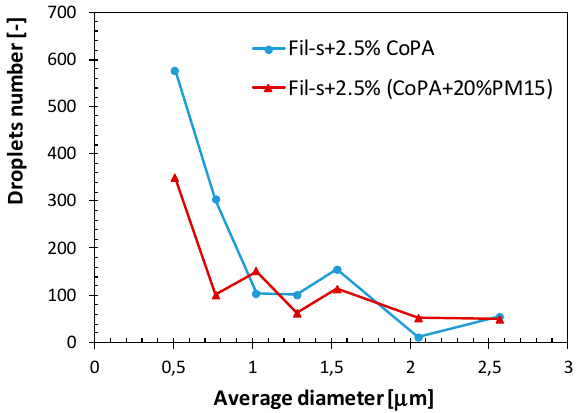
Figure 8. SEM image of the sample Fil-s + 2.5%(CoPA+20%PM15) captured on the section cryo-fractured and etched with formic acid.